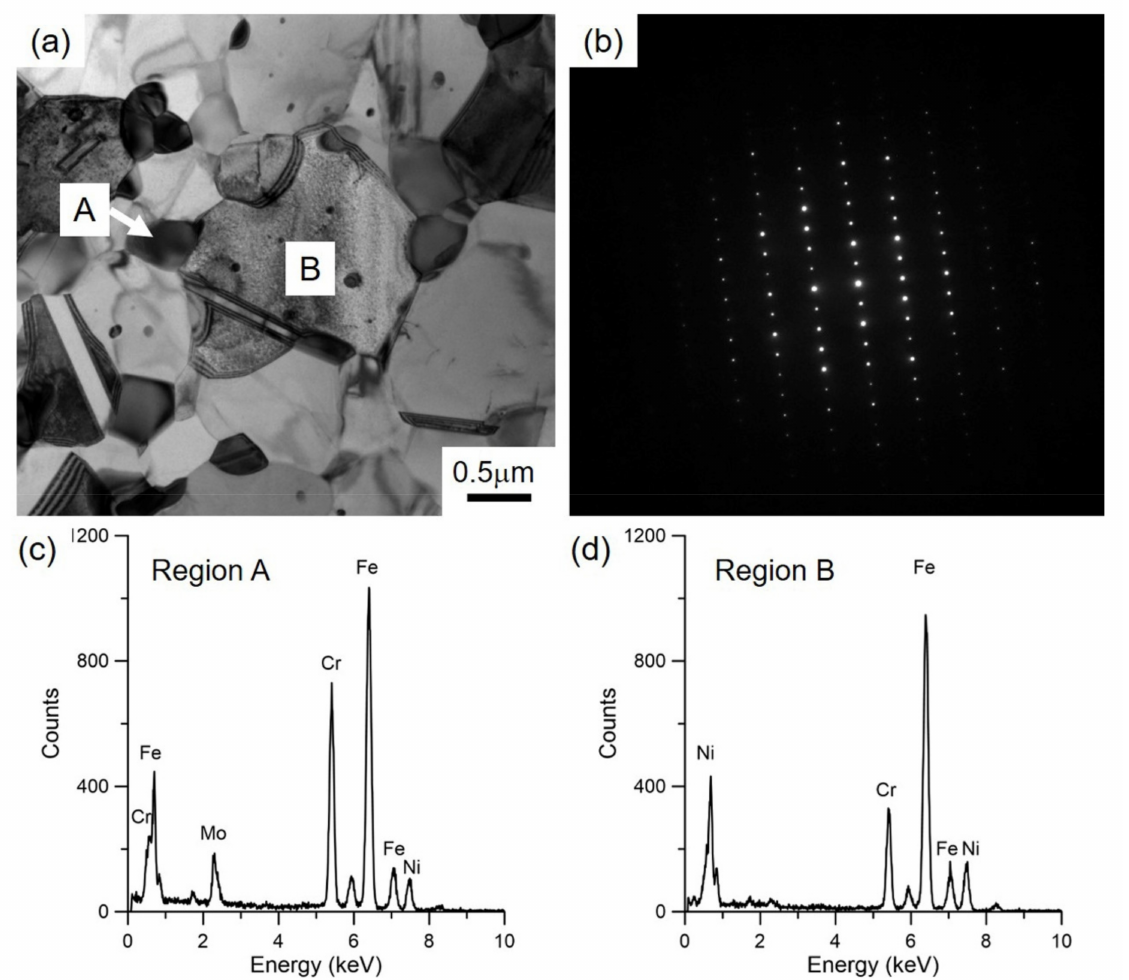
Figure 3. TEM observations of UFG 316LN stainless steel annealed at 800 ◦ C: ( a ) morphology; ( b ) diffraction pattern; ( c ) chemical compositions of precipitations; ( d ) chemical compositions of base